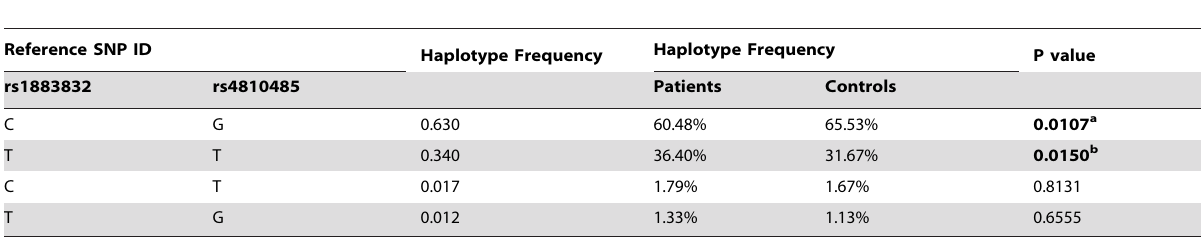
Table 3. CD40 haplotype frequencies in breast cancer patients and